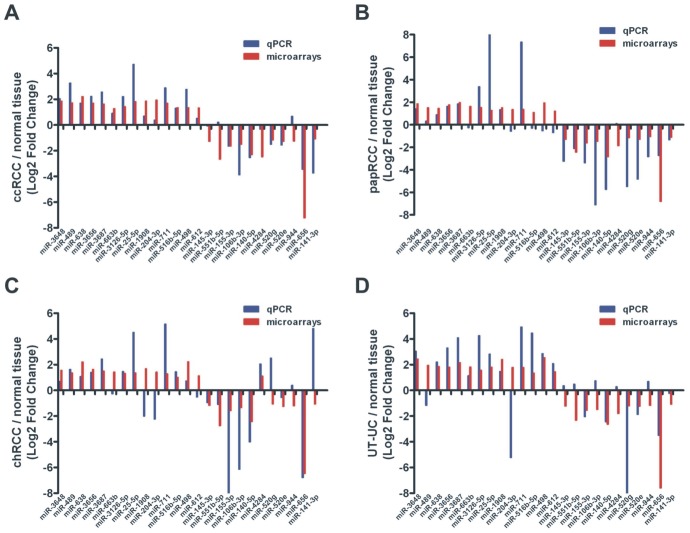
Correlation between microarrays and qRT-PCR.Median log2 fold change expression levels of the 14 most up-regulated and 11 most down-regulated miRNAs between ccRCC, papRCC, chRCC and UT-UC and the normal kidney tissue, as determined by both qRT-PCR and microarray analysis. As shown in the figure, qRT-PCR and microarray results were highly compatible. The most identical results between the two techniques were those for ccRCC, which was expected due to the high sample number (Pearson’s CC = 0.778, p<0.001). The qRT-PCR results for papRCC, chRCC and UT-UC also revealed similar deregulation patterns with those of the microarray experimentation, however the correlation coefficients were lower, apparently due to small sample number (in papRCC, CC = 0.596, p = 0.002; in chRCC CC = 0.570, p = 0.003; in UT-UC, CC = 0.517, p = 0.009).